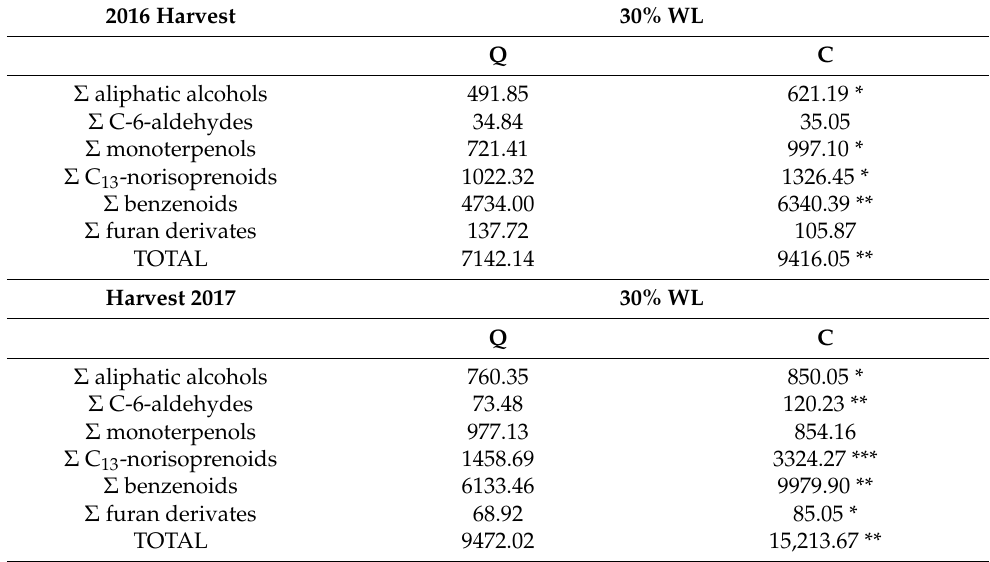
Table 4. Content of glycosidic aroma precursors in 2016 and 2017, in C (Colombara) and Q (Quaiara). Within rows, *; **; *** values are different at α ≤ 0.05, 0.01, and 0.001. Contents are expressed as µ g 1-heptanol (IS)/Kg d.g. (dried